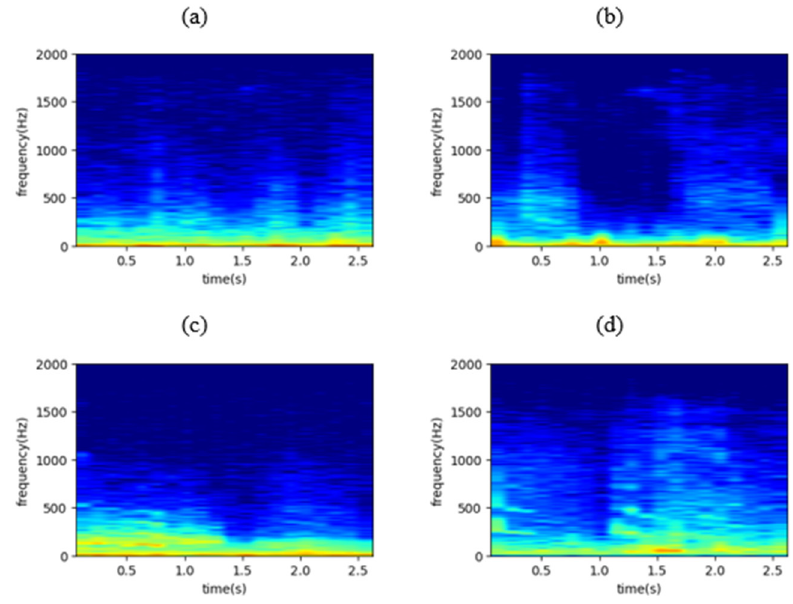
Figure 2. The spectrogram of ( a ) a normal respiratory cycle, ( b ) a respiratory cycle containing crackles, ( c ) a respiratory cycle containing wheezes, and ( d ) a respiratory cycle containing both crackles and wheezes, where x axis represents time in seconds and y axis represents frequency in Hz.